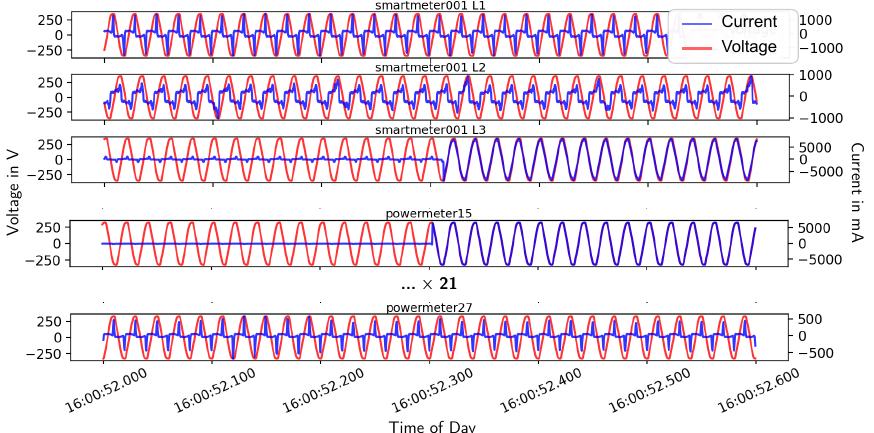
Figure 7. Voltage (red) and current (blue) waveforms of the SmartMeter, powermeter15 and power- meter27. The recording was taken on 9 June 2020 at around 4:00 p.m. The same appliance switch-on event of the espresso machine is visible in the recording of L3 of the smartmeter and of